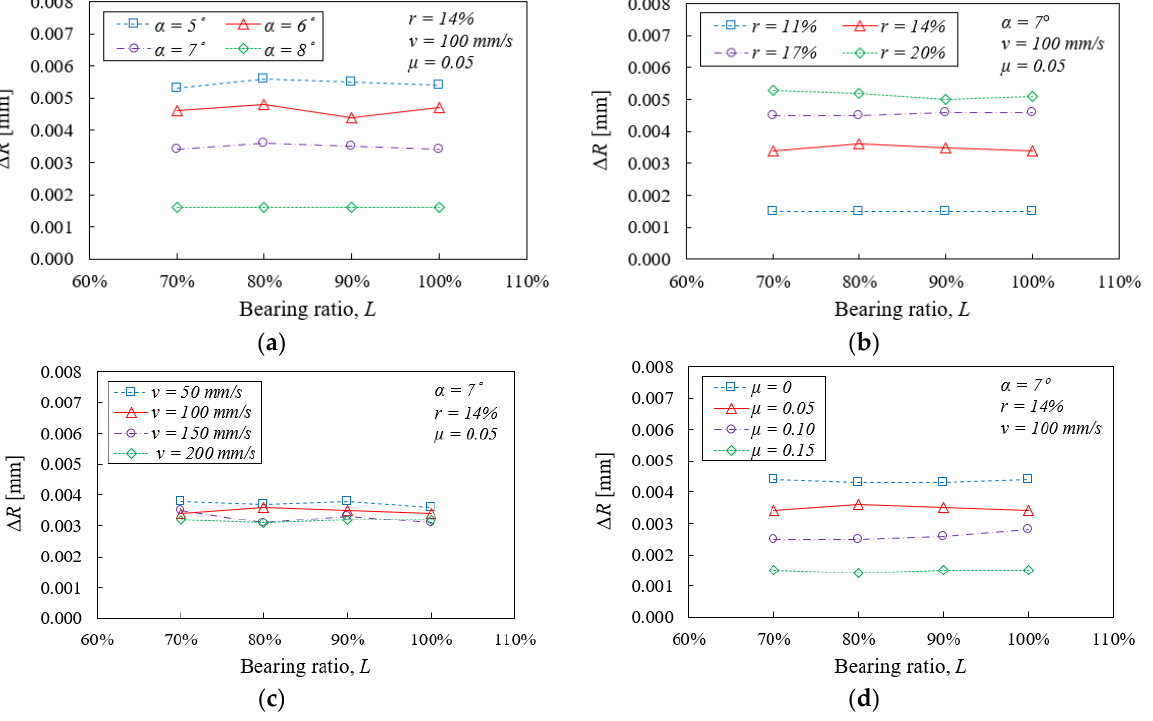
Figure 7. Effects of bearing length on ∆ R under different conditions. ( a ) Different semi-die angles; ( b ) different reduction ratios; ( c ) different drawing speeds; ( d ) different friction coefficients.